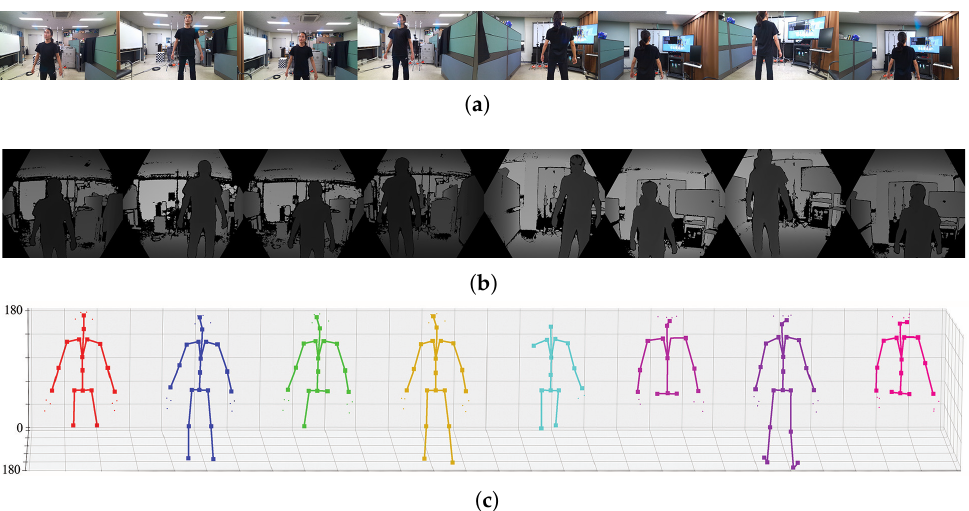
Figure 8. 3D pose estimation result using the SDK of Azure Kinect ( a ) RGB image, ( b ) calibrated depth image, ( c ) estimated joint set in eight view-points.